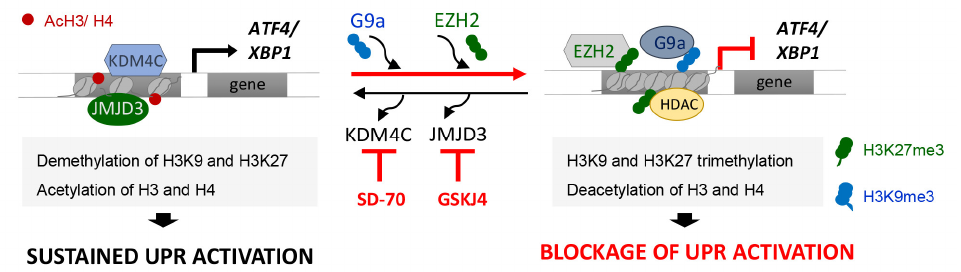
Figure 9. Blockage of the KDM4C and JMJD3 HDMs allows the inhibition of ATF4 and XBP1 expression under UPR activation in renal tubular cells. Modulation of the methylation levels in the H3K9 and H3K27 histone marks, mediated by the G9a and EZH2 histone methyltransferase (HMTs) enzymes or the KDM4C and JMJD3 histone demethylases (HDMs), enables the expression of the ATF4 and XBP1 transcription factors and their downstream signaling to be regulated. Treatment with the SD-70 and GSKJ4 epigenetic inhibitors (red lines) leads to an increased recruitment of HMTs and enhanced H3K9 and H3K27 methylation levels at ATF4 and XBP1 genes, reducing their expression and tip the balance toward reduced signaling mediated by these transcription factors, and thereby the renal damage under sustained ER stress.